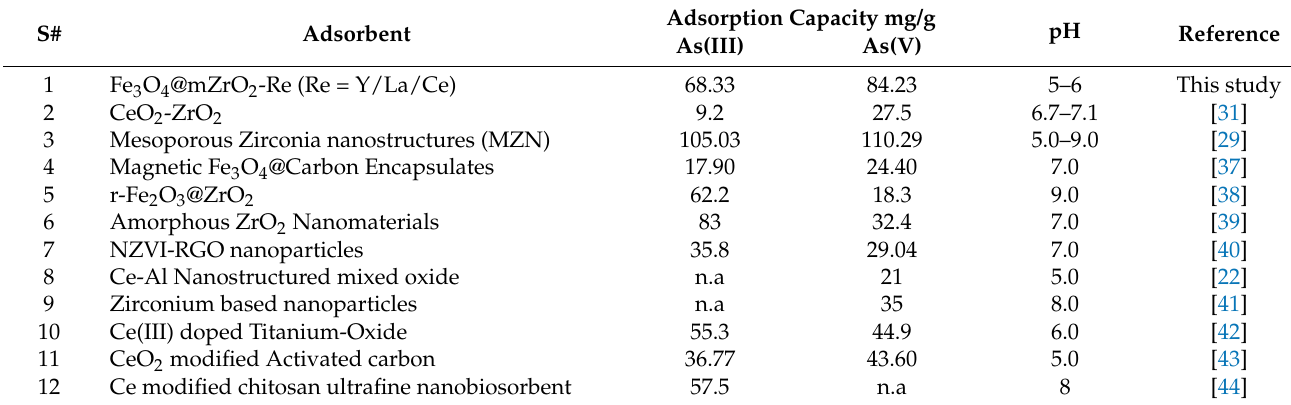
Table 8. Comparison of adsorption capacity of Fe 3 O 4 @mZrO 2 -Re with other relevant